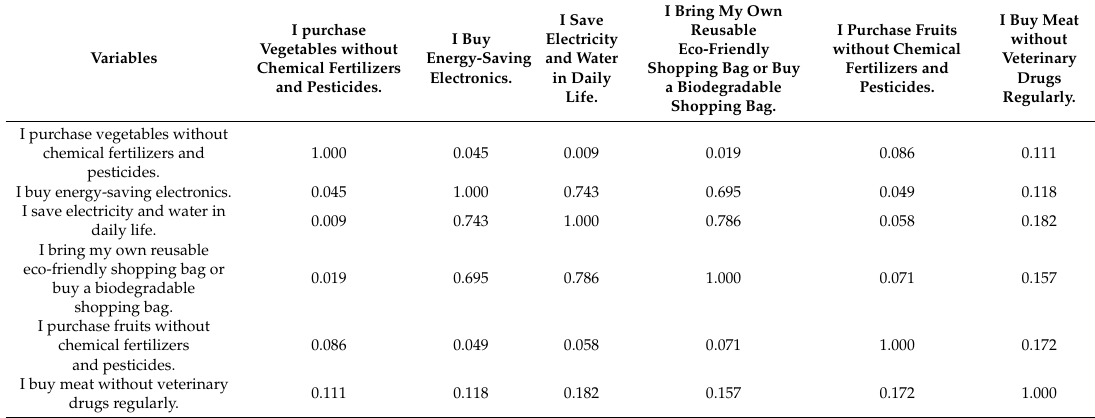
Table A1. Results of the correlation of the variables. KMO: Kaiser–Meyer–Olkin